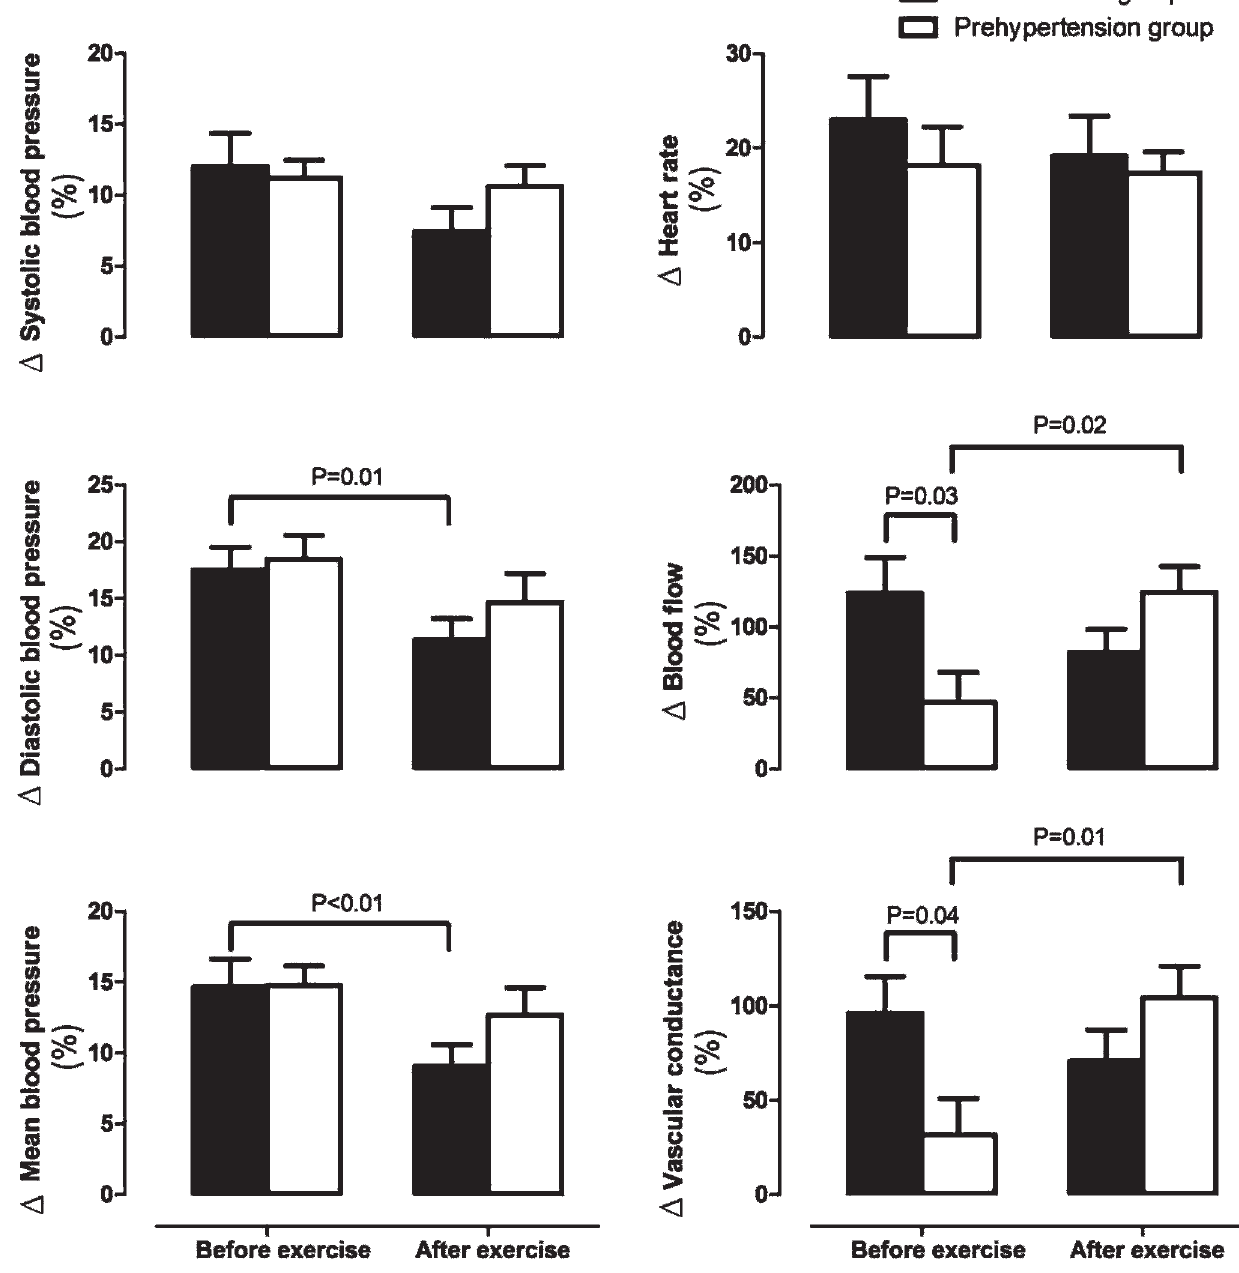
Figure 2 - Percent change of hemodynamic responses to mental stress, adjusted for gender, before and after an exercise bout in subjects with prehypertension